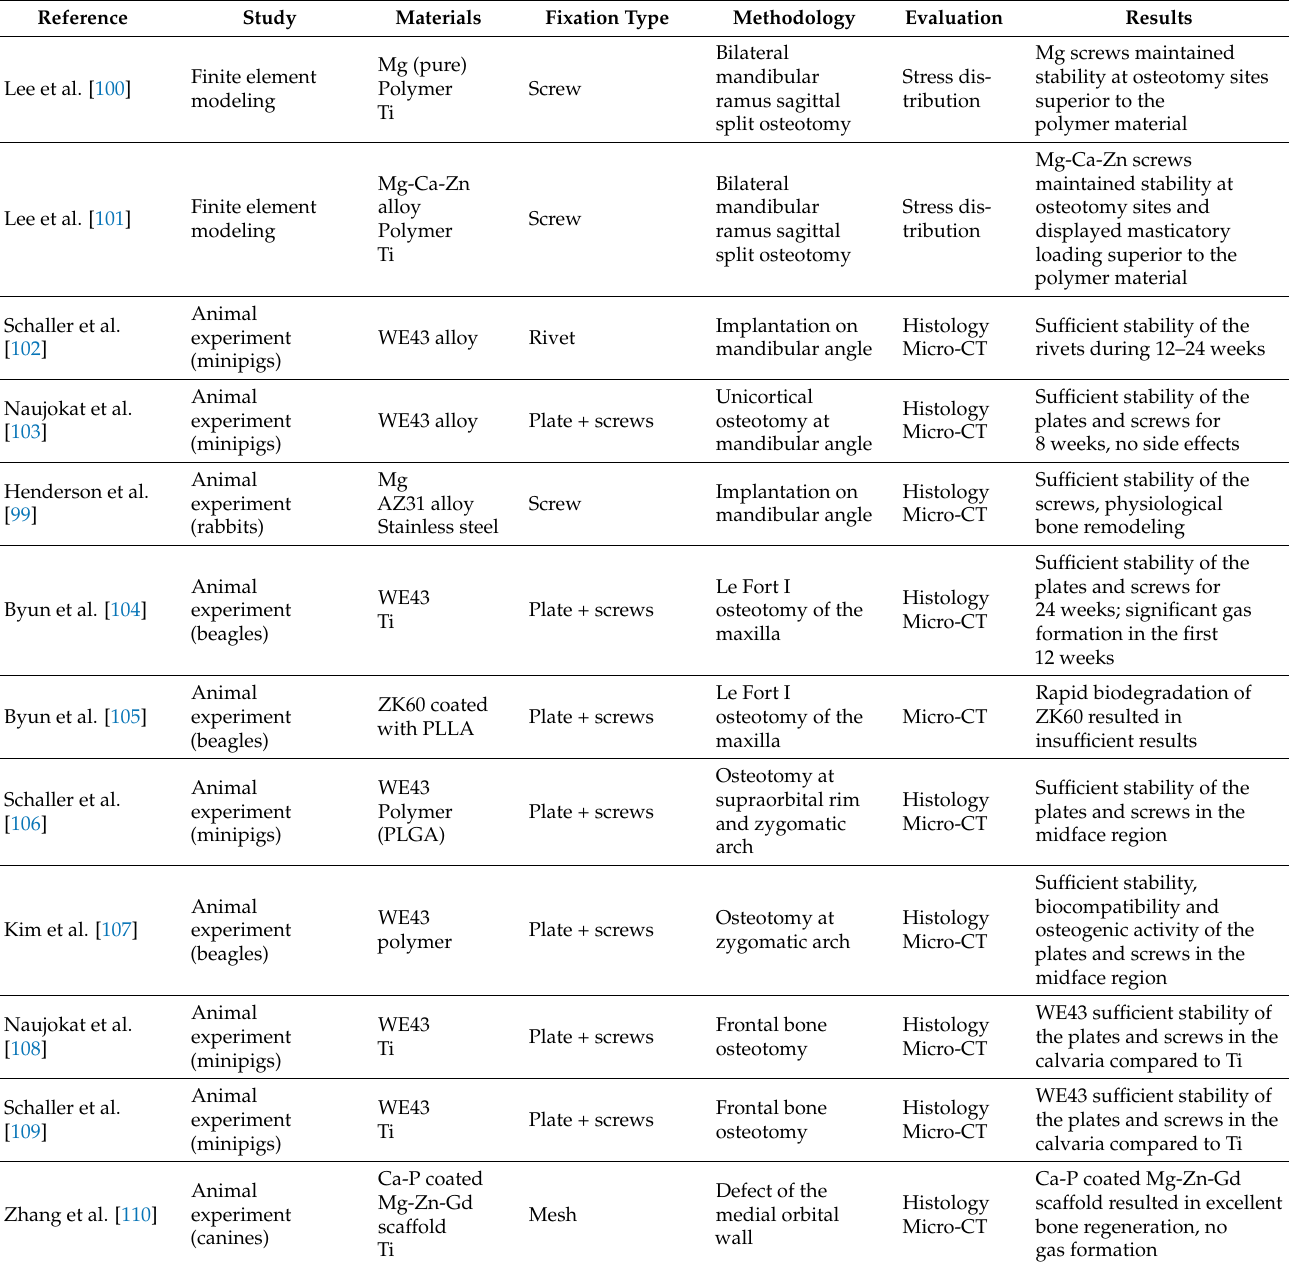
Table 1. Magnesium (Mg)-based materials for osteosynthesis of maxillofacial